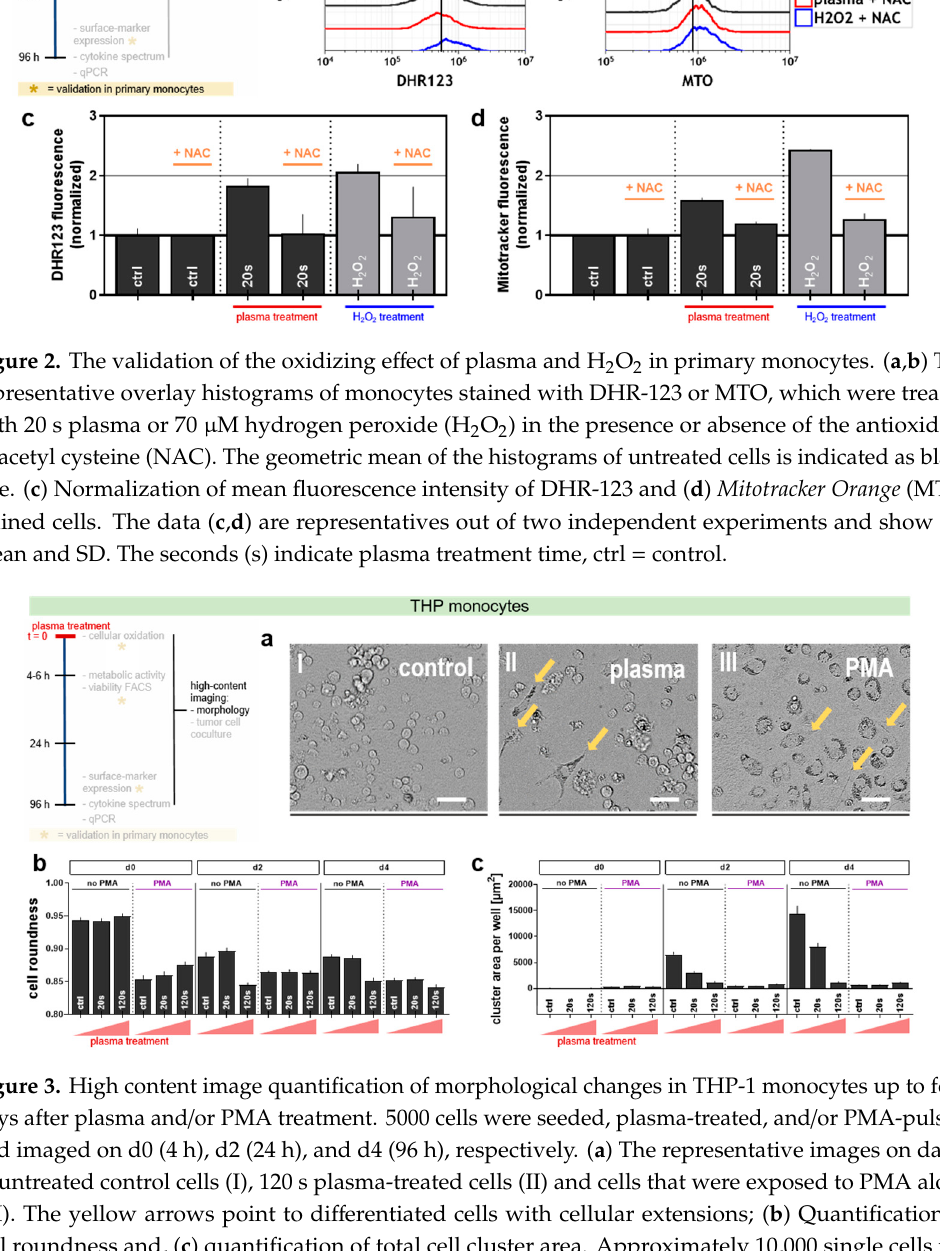
Figure 2. The validation of the oxidizing effect of plasma and H 2 O 2 in primary monocytes. ( a , b ) The representative overlay histograms of monocytes stained with DHR-123 or MTO, which were treated with 20 s plasma or 70 µM hydrogen peroxide (H 2 O 2 ) in the presence or absence of the antioxidant N- acetyl cysteine (NAC). The geometric mean of the histograms of untreated cells is indicated as black line. ( c ) Normalization of mean fluorescence intensity of DHR-123 and ( d ) Mitotracker Orange (MTO) stained cells. The data ( c , d ) are representatives out of two independent experiments and show the mean and SD. The seconds (s) indicate plasma treatment time, ctrl = control.